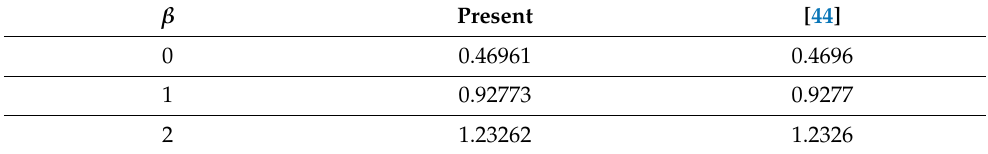
Table 6. Comparison of results for − θ (cid:48) ( 0 ) with numerical results in [45] when φ = 0 and β = 1. Pr Present [45]